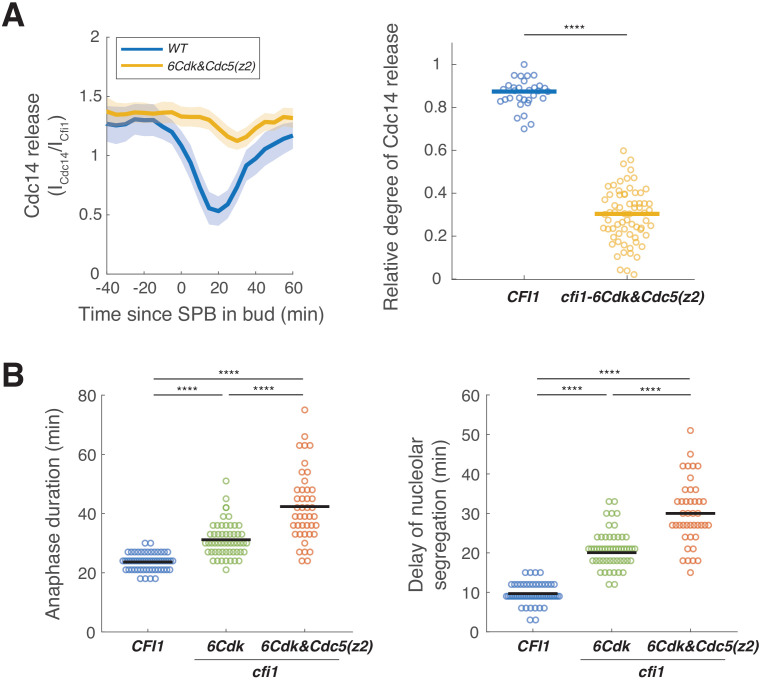
Mutating both CDK and Cdc5 sites in Cfi1/Net1 results in severe delays in mitotic exit and nucleolar segregation.(A) Cdc14 nucleolar release kinetics in cells harboring wild-type CFI1/NET1 (A41387, n = 39 cells) or CFI1/NET1 phospho-mutants for CDK sites combined with Cdc5 sites in zone 2 (A41691, n = 79 cells). Cells were grown at 25°C in SC medium + 2% glucose and imaged every 5 min for 5 hr. Single cell traces were aligned to the frame where the daughter spindle pole body (dSPB) entered the bud and averaged. Solid lines represent the average. Shaded areas represent 95% confidence intervals. Each dot represents a single cell. Solid lines represent the median. ****p<0.0001 by two-sided Wilcoxon rank sum test. (B) Distribution of anaphase duration and relative delay of nucleolar segregation for different CFI1/NET1 phospho-mutants (A41436, A41692, and A41694; n = 58, 55, and 44 cells respectively) measured using the SPB marker Spc42-eGFP and the nucleolar marker Cfi1/Net1-mScarlet-I. Cells were grown at 25°C in SC medium + 2% glucose and imaged every 3 min for 4 hr. Each dot represents a single cell. Solid lines represent the median. ****p<0.0001 by two-sided Wilcoxon rank sum test.